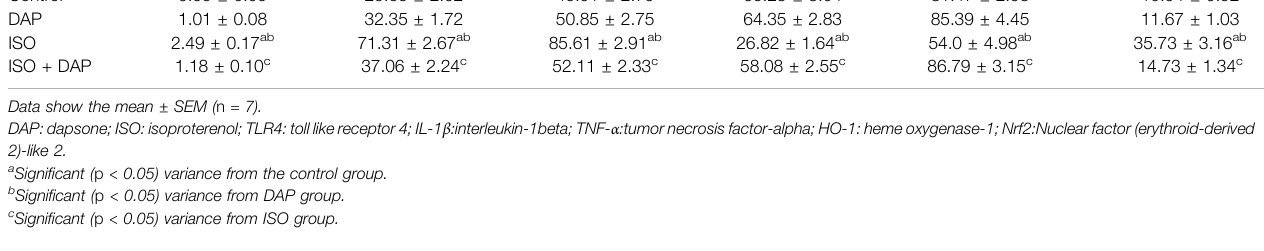
TABLE 3 | Effect of DAP on cardiac TLR4, TNF- α , IL-1 β , HO-1, Nrf-2, caspase-3. Groups Cardiac TLR4 (ng/g tissue)